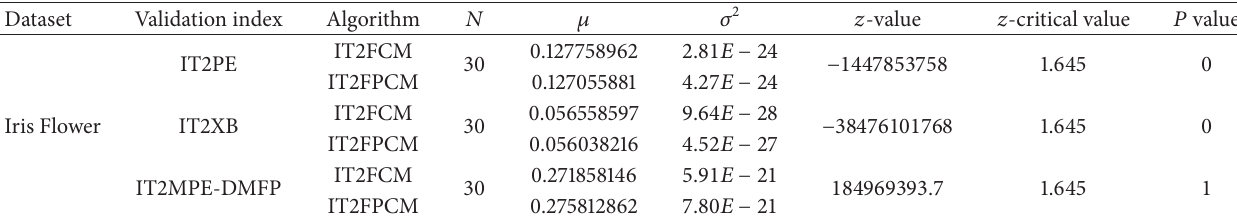
Table 12: Hypothesis testing for the IT2PE, IT2XB, and IT2MPE-DMFP indices of validation for the Iris Flower dataset